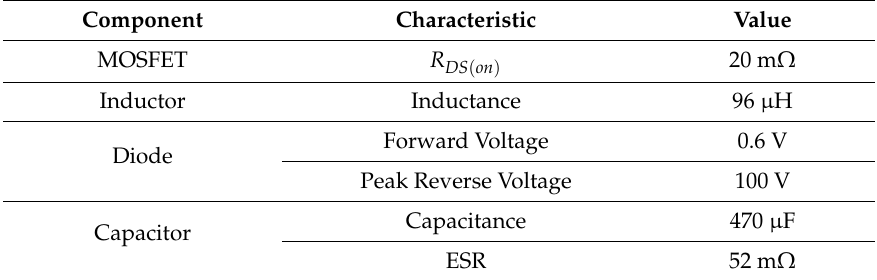
Table 4. Buck converter component values.